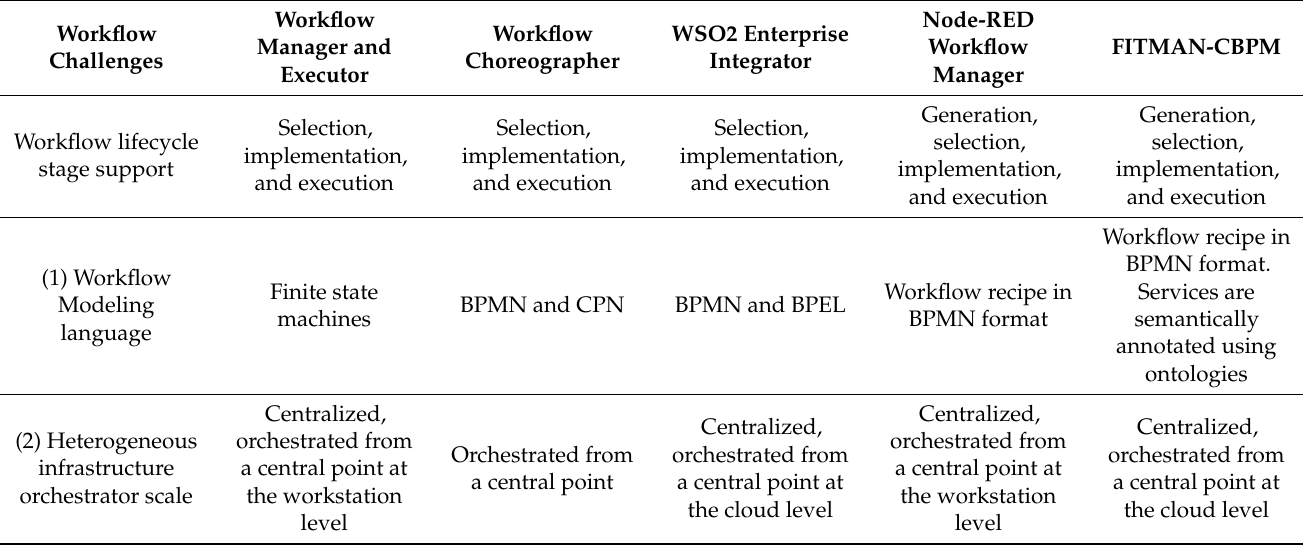
Table 1. Workflow management challenges-and how they get addressed by each